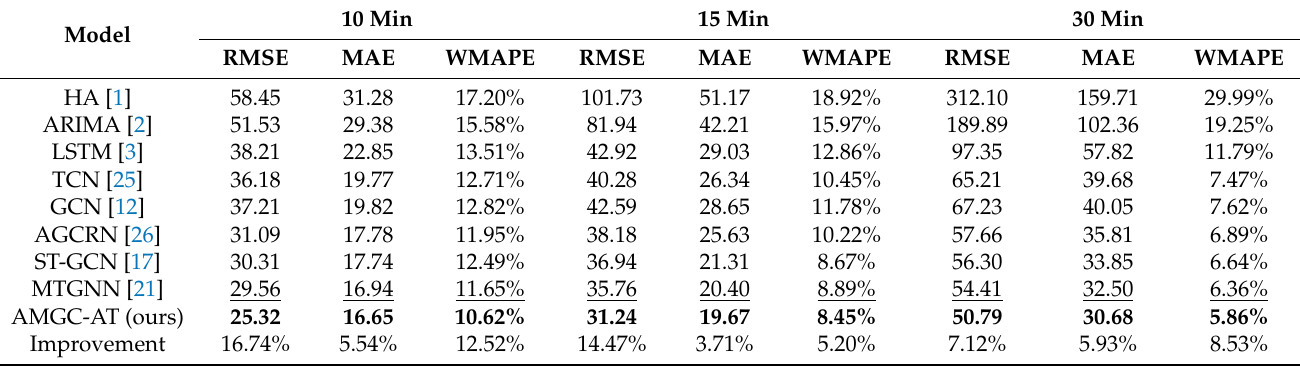
Table 3. Performance comparison of different methods on in-flow